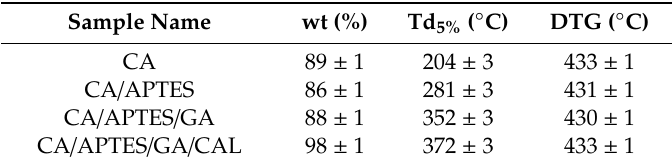
Table 1. The wt (%), Td 5% and the DTG values for the CA membrane before and after the modification process. Three different samples were analyzed for calculating the standard deviation.